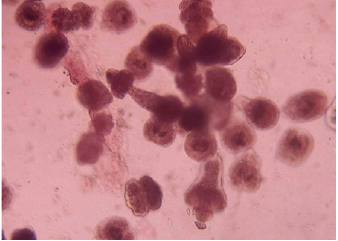
Fig. 7. Control group on the seventh day (144). (Power x100 magnification)